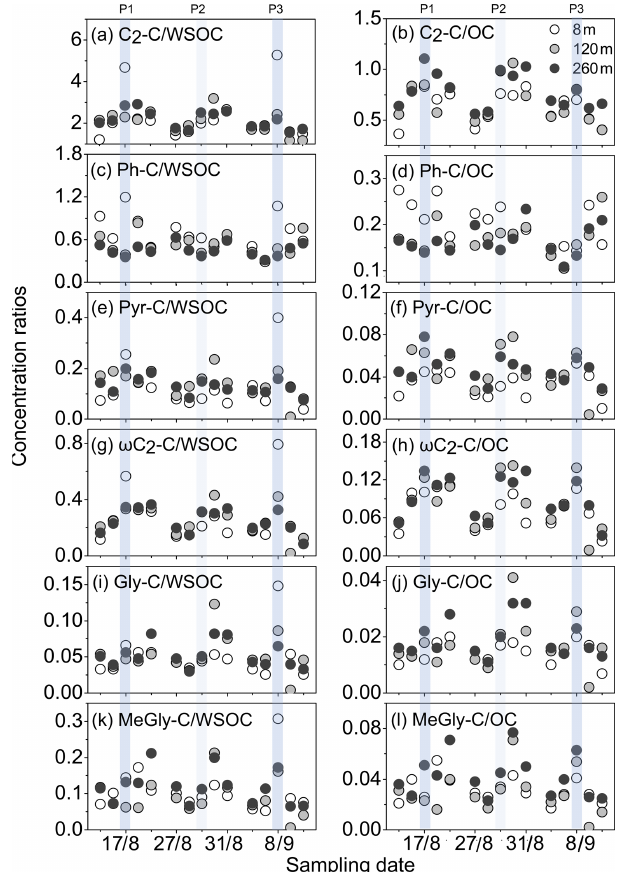
Figure 9. The relative contributions of C 2 , Ph, ω C 2 , Pyr, Gly and MeGly to carbonaceous fractions (WSOC and OC) on clean, trans- formation, and polluted days. Two moderately polluted days (P1 and P3) and one lightly polluted day (P2) are marked for further